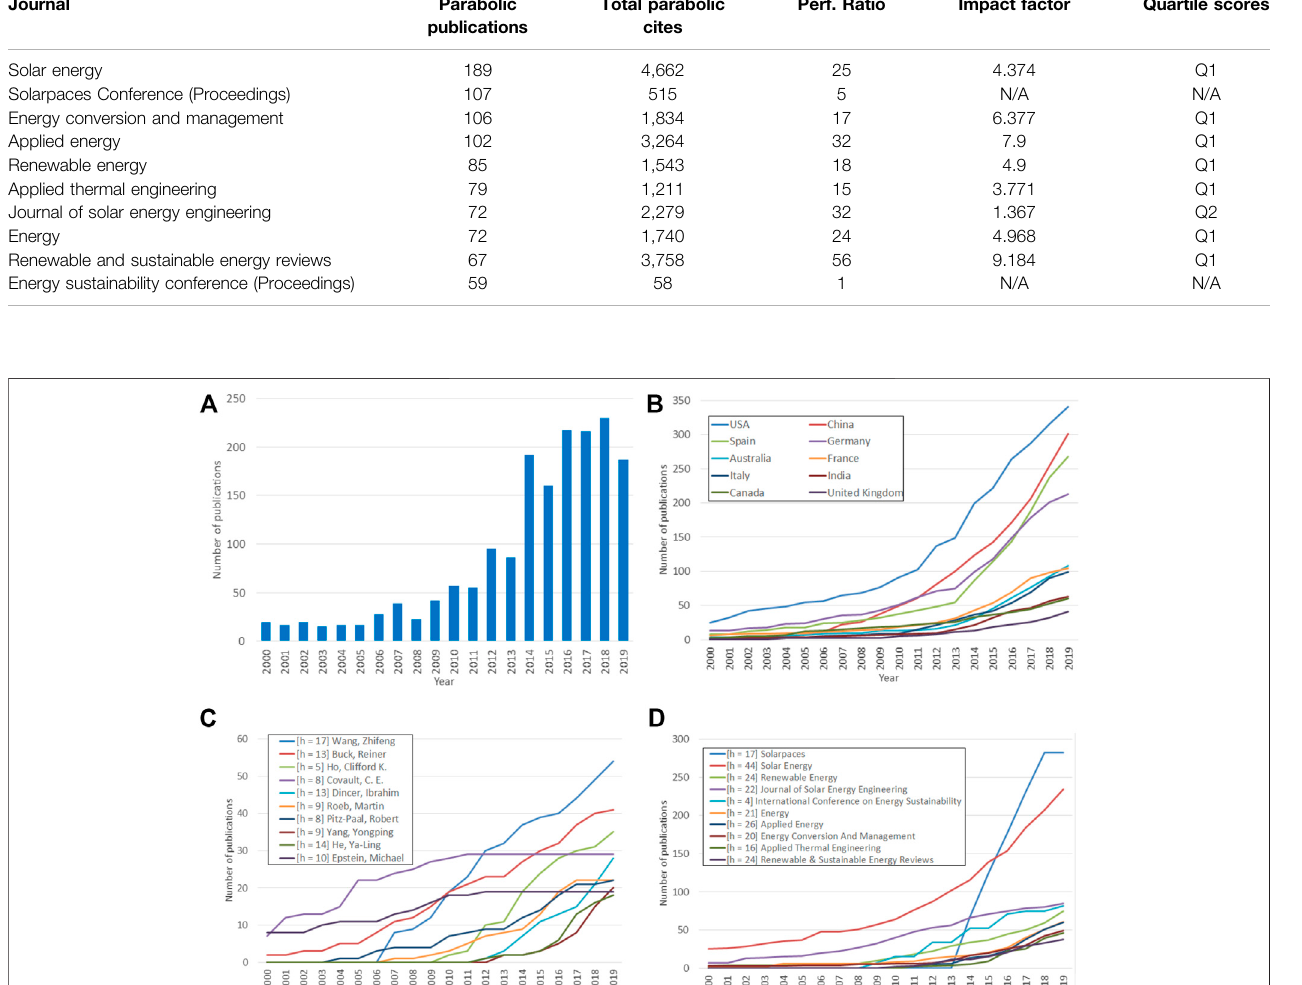
Frontiers in Mechanical Engineering |